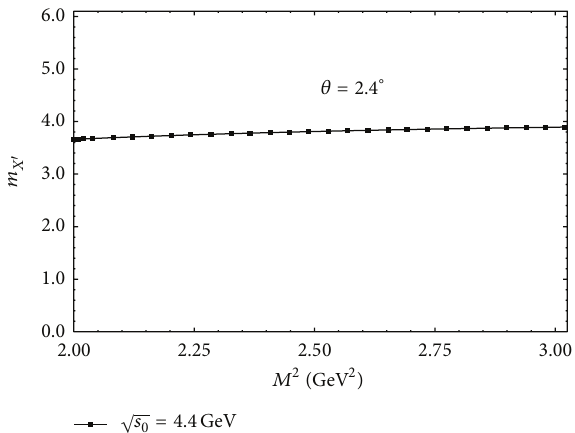
Figure 1: The dependence of the mass of the 𝑋 󸀠 state on Borel mass square 𝑀 2 for the mixing angle 𝜃 = 2.4 0 , at the fixed value of the continuum threshold √𝑠 0 = 4.4 GeV.